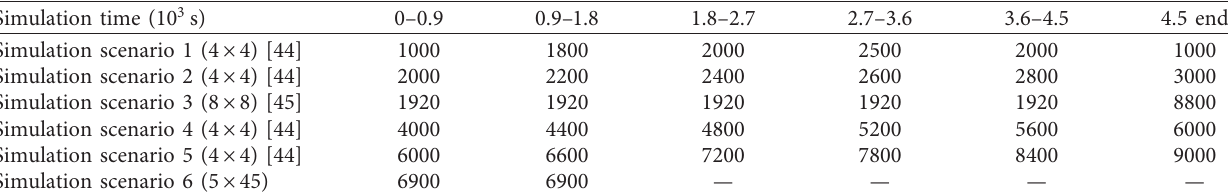
Table 3: The traffic demand for each simulation scenario.